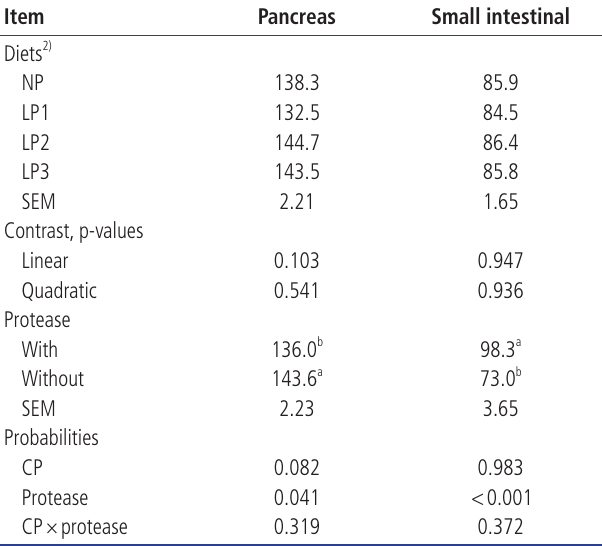
Table 8. Effect of crude protein level and protease enzyme supplementation on endogenous protease activity in broiler chickens at 35 days of age 1) Item